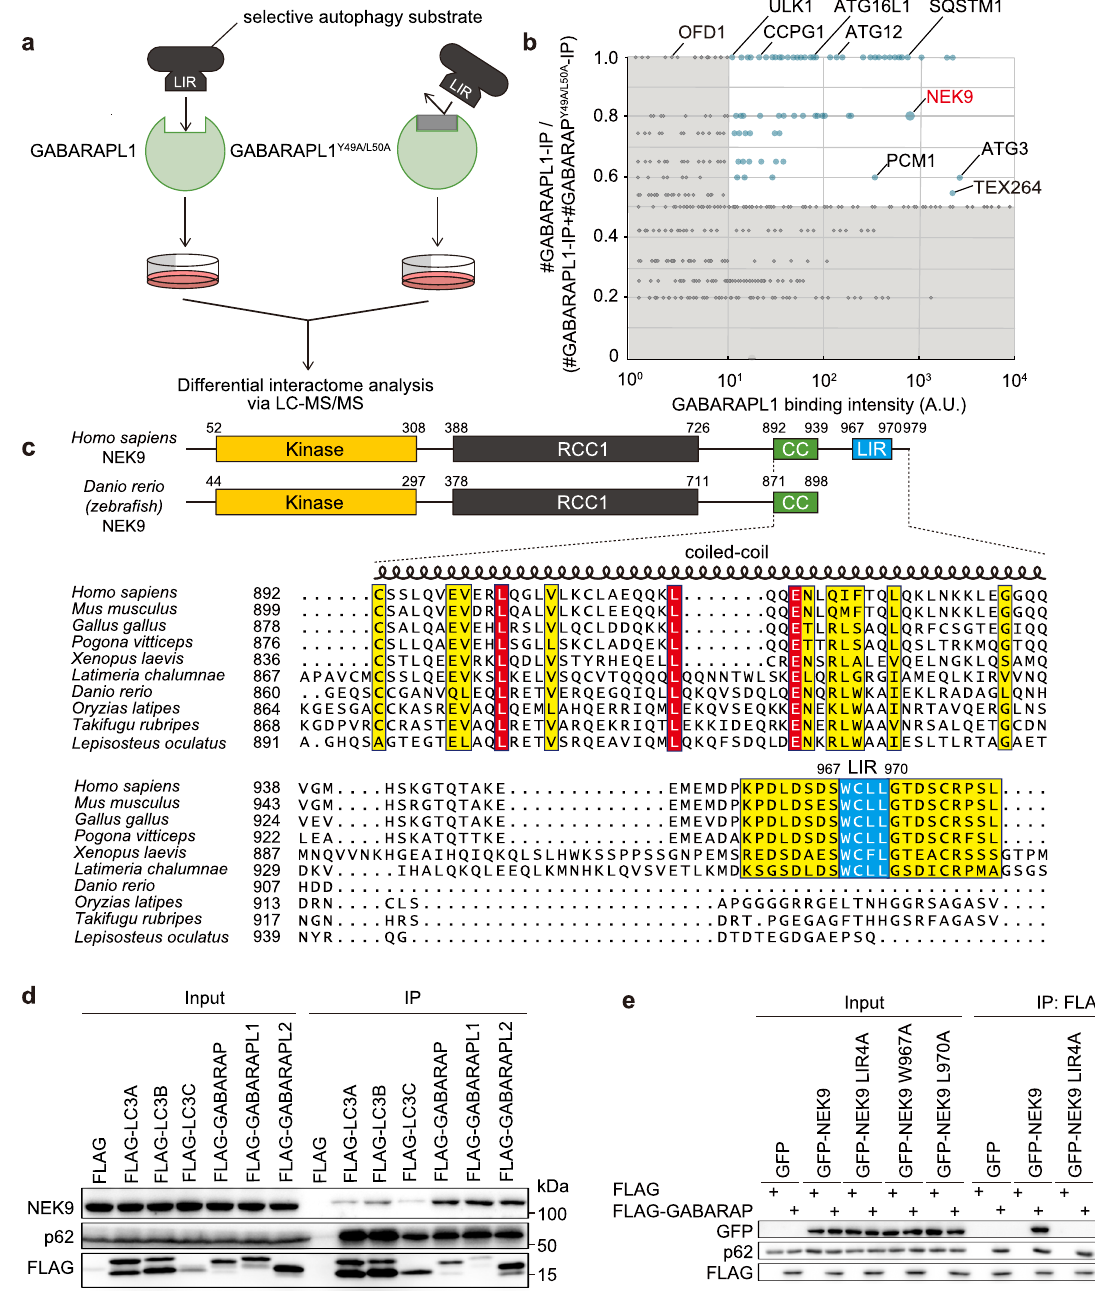
Fig. 1 Differential interactome screen identi fi ed NEK9 as a GABARAP-interacting protein. a Scheme of the differential interactome screen to identify substrates or adaptors of selective autophagy using GABARAPL1 and its LIR docking site mutant GABARAPL1 Y49A/L50A . b Results of the differential interactome screen. Four independent immunoprecipitation and mass spectrometry (MS) analyses were conducted. The number of times each protein was detected is shown as #GABARAPL1-IP or #GABARAPL1 Y49A/L50A -IP. The x - and y -axes represent GABARAPL1 binding intensity and the #GABARAPL1-IP / (#GABARAPL1-IP + #GABARAPL1 Y49A/L50A -IP) ratio, respectively. The area de fi ned by x < 10 or y < 0.5 is colored gray. See also Supplementary Data 1. c Structures of Homo sapiens and Danio rerio NEK9 and a multiple sequence alignment of NEK9 proteins in vertebrates. Identical and similar residues are colored in red and yellow, respectively. LIR was predicted by iLIR search. KD, kinase-domain; RCC1, RCC1-repeats; CC, coiled-coil. d Immunoprecipitation of FLAG-ATG8s in HEK293T cells. e Co-immunoprecipitation of FLAG-GABARAP and wild-type or mutant GFP-NEK9 in HEK293T cells. In GFP-NEK9 LIR4A, the LIR residues (WCLL) were substituted by four alanines. Data are representative of three independent experiments in ( d ) and ( e